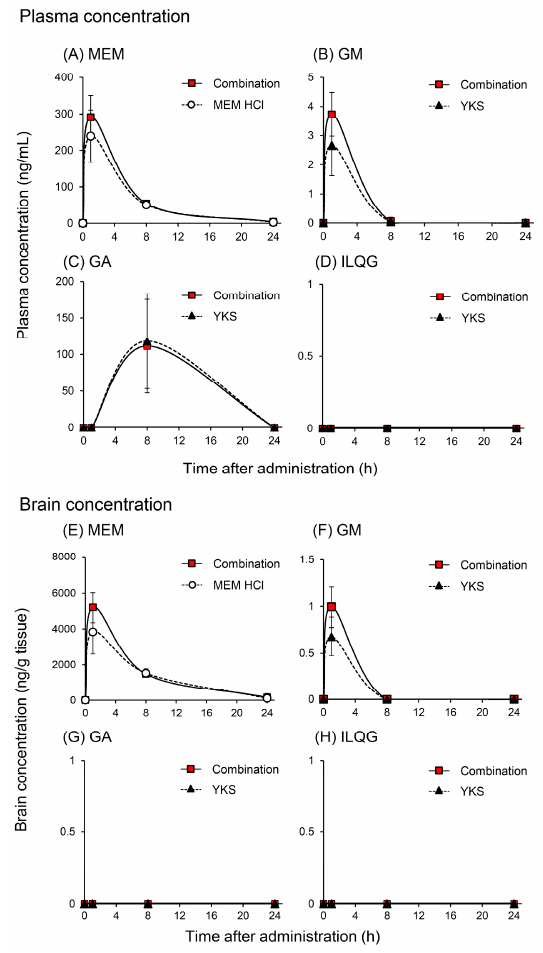
Figure 1. Concentration–time profiles of memantine (MEM) and the three yokukansan (YKS)-derived ingredients in the plasma ( A – D ) and brain ( E – H ) of mice after oral administration of MEM, YKS, or their combination. MEM hydrochloride (5 mg/kg), YKS (1 g/kg), or their combination was orally administered to fasted mice. Plasma and brain samples were obtained at 0 (pre-administration), 1, 8, or 24 h after administration. Data represent mean ± standard deviation ( n = 4,5). No statistical